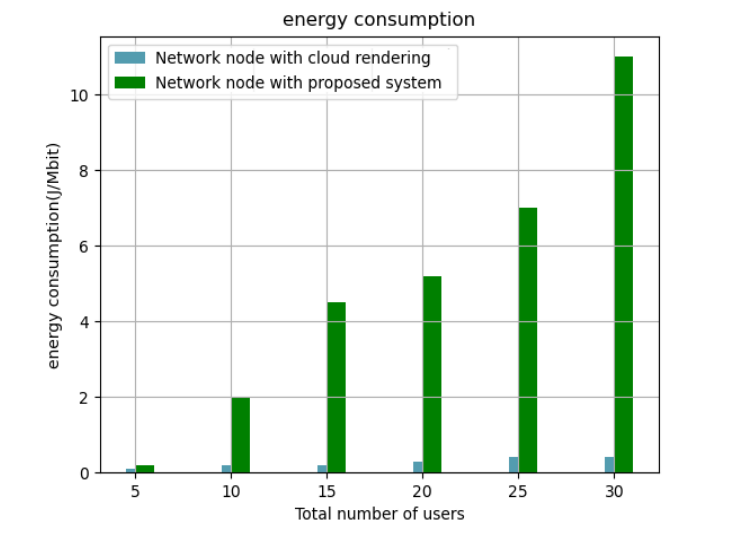
Figure 9. Total number of